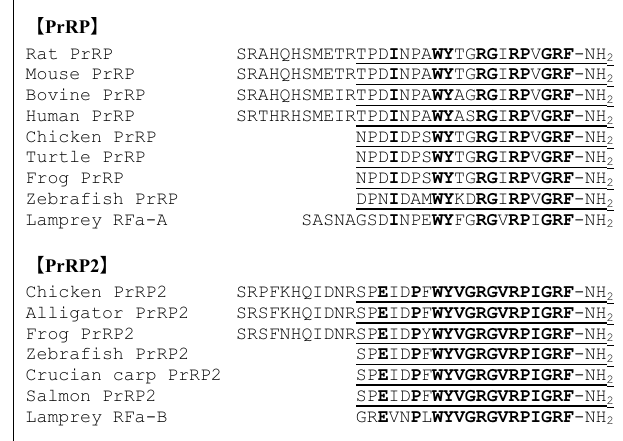
FIGURE 1 | Identified or predicted amino acid sequences of PrRP and PrRP2 in vertebrates . Bold characters indicate conserved amino acid residues. Identified or predicted PrRP-20 or PrRP2-20 peptide sequences are underlined.